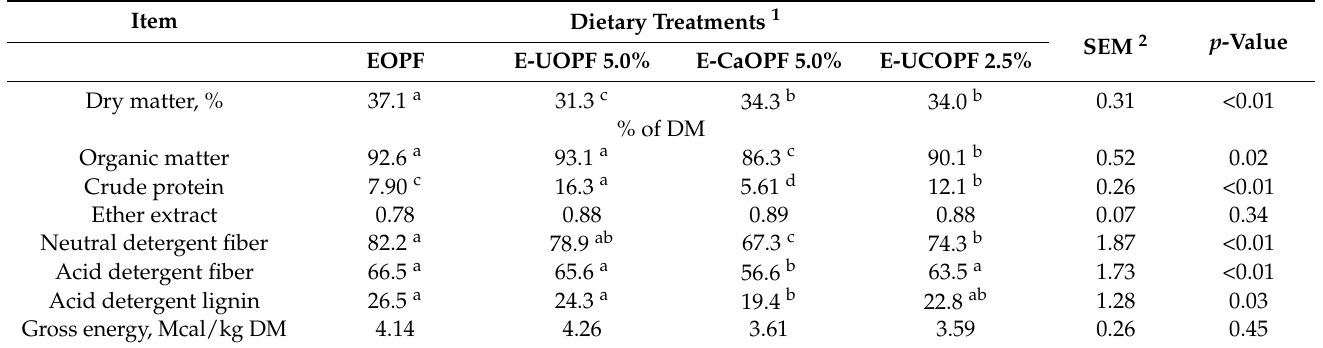
Table 2. Chemical composition of ensiled oil palm fronds supplemented with urea-calcium hydroxide.